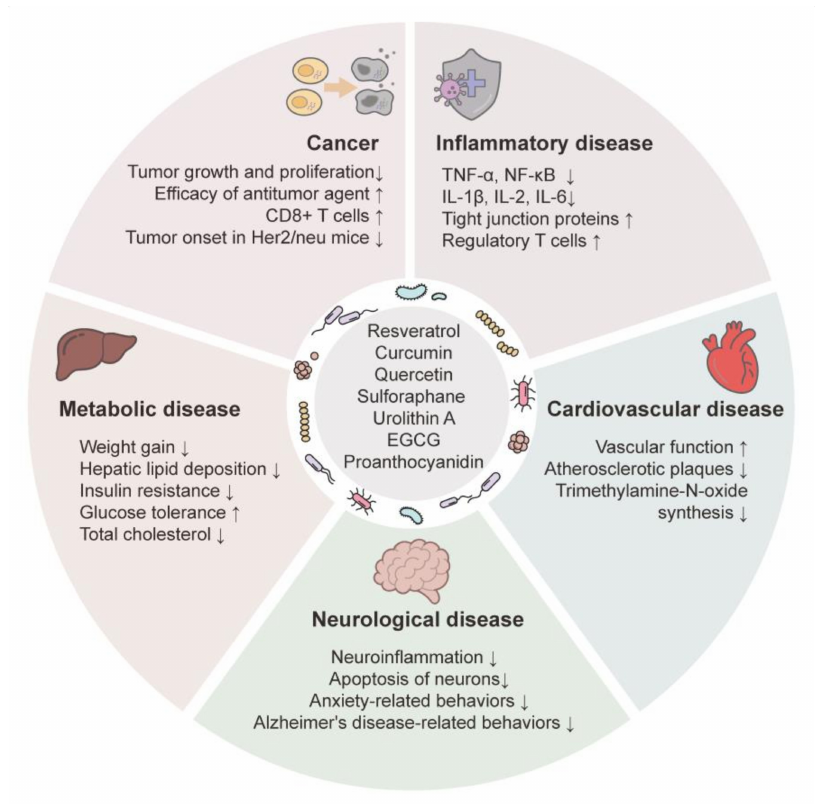
Figure 4. Effects of phytochemicals on diseases via colonic microbiota modulation. Effects of phytochemicals on physiology and pathology indicate associations with the composition and diversity of colonic microbiota. Arrows indicate substantial increases ( ↑ ) and decreases ( ↓